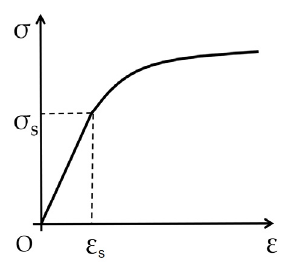
Figure 6. Power function material model.